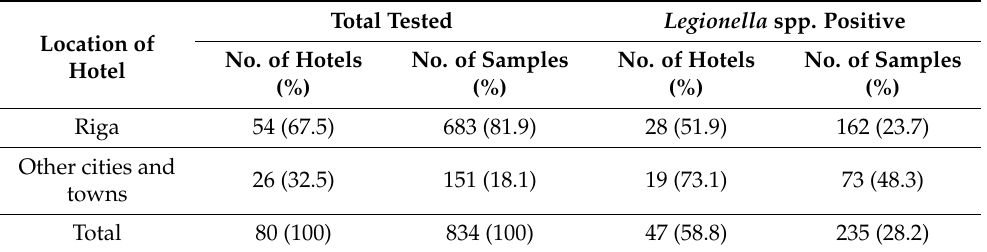
Table 1. Prevalence of Legionella spp. in water samples from hotels in